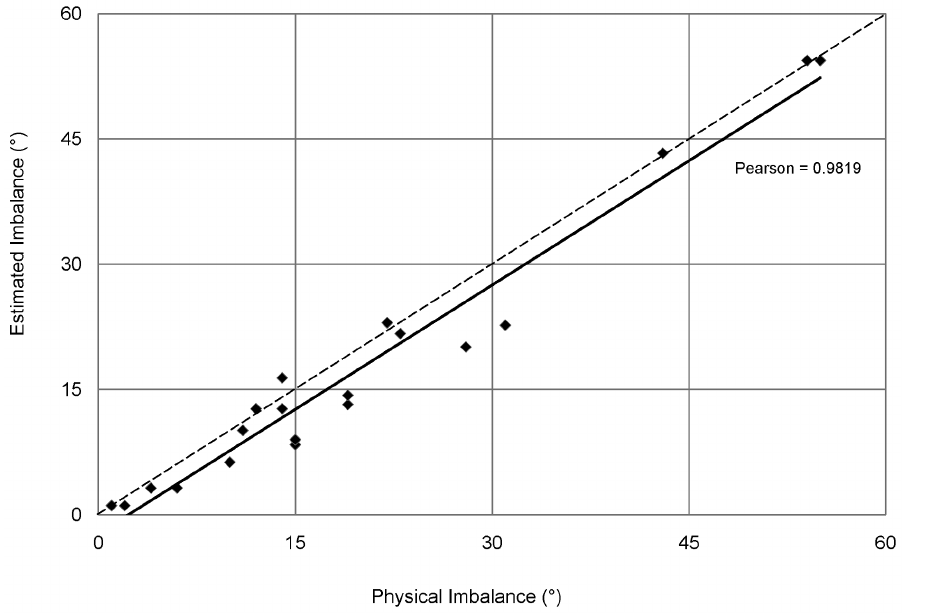
Figure 4. Estimated vs. physical replichore balance. While the calculator slightly underestimated replichore balance (dashed line = perfect fit), the estimates of replichore balance were statistically the same as the physically mapped arrangement types ( P , 0.01, paired Student’s t test; Pearson’s correlation =0.982).